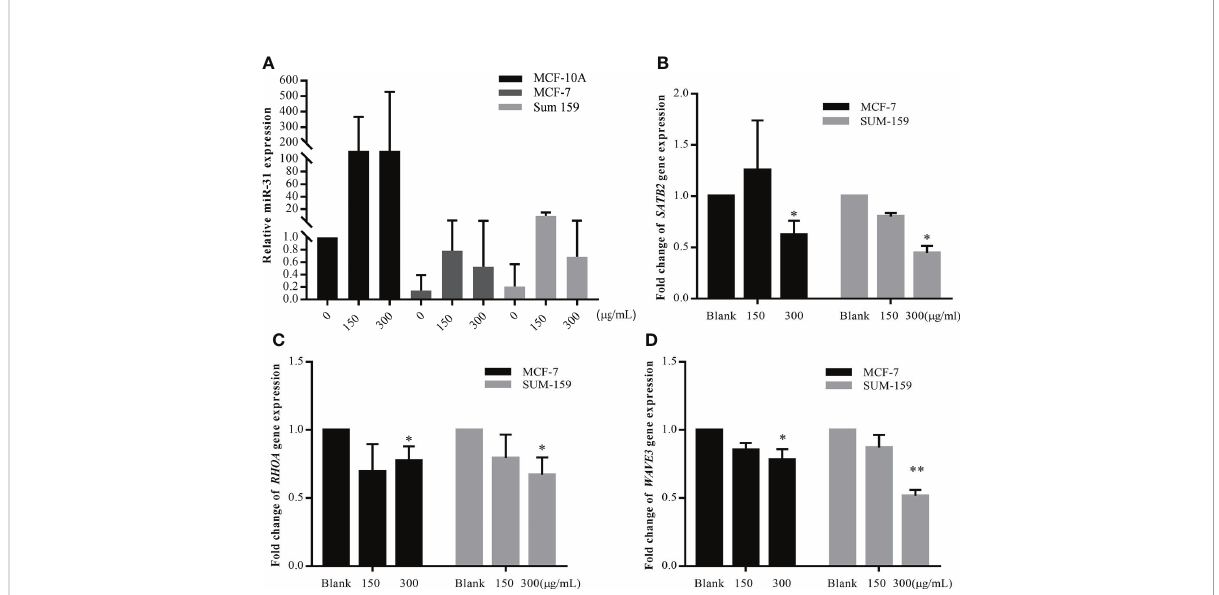
FIGURE 2 Detection of miR-31 and its target gene expression under the treatment of GBK in different breast cell lines. (A) MCF-10A, MCF-7, and SUM-159 cells were treated with different concentration of GBK. Total RNA was extracted after 48 hours for miRNA expression detection by RT-qPCR. Quanti fi cation of miR-31 expression in three different breast cell lines after application of different concentrations of GBK was shown. (B-D) Expression of SATB2 , RHOA and WAVE3 in MCF-7 and SUM-159 cells after treatment with different concentrations of GBK was analyzed by RT- qPCR. Data are presented as mean ± s.e.m. of three independent experiments. Student ’ s t test, *p < 0.05, **p <